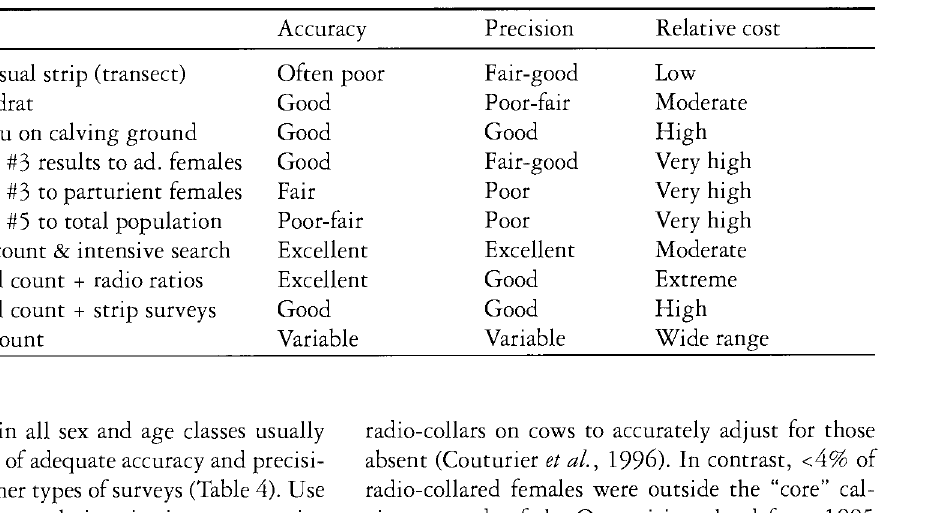
Table 4. Generalized and subjective rating of the accuracy and precision of some surveys used to enumerate large forest-tundra herds of